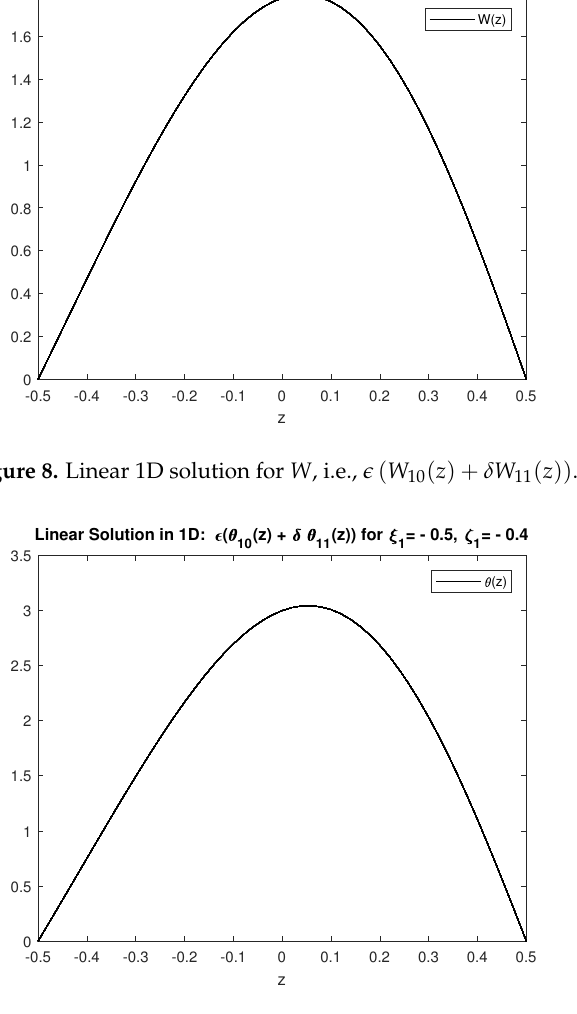
Figure 9. Linear 1D solution for θ i.e., (cid:101) ( θ 10 ( z ) + δθ 11 ( z ))